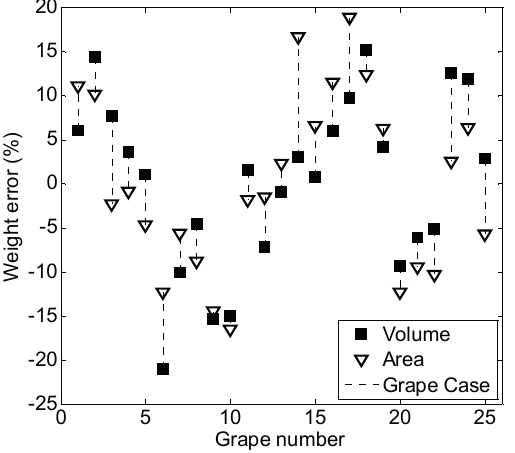
Figure 7. Individual error obtained when comparing the real and estimated weight of 25 clusters of grapes in consecutive images. The grape weight was predicted by using the estimated area and deduced volume of the cluster of